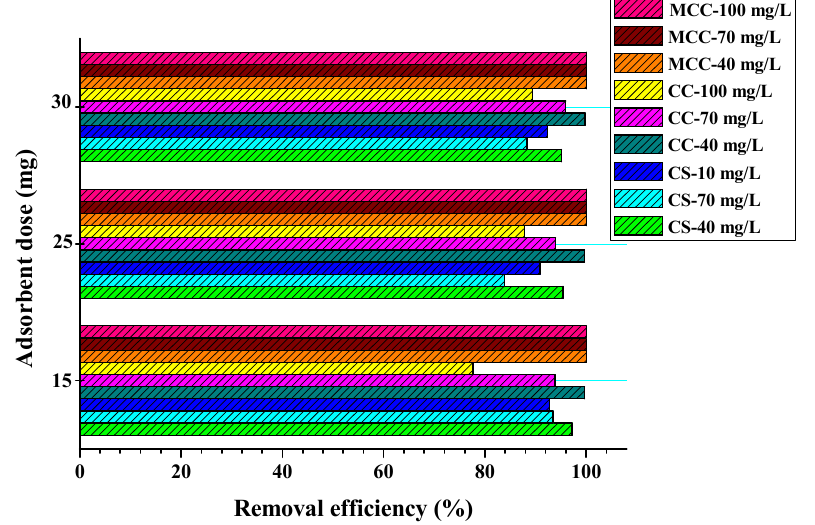
Figure 4. Congo red removal efficiency on coconut shell bioadsorbents at different initial concentra- tions and adsorbent dosage conditions.